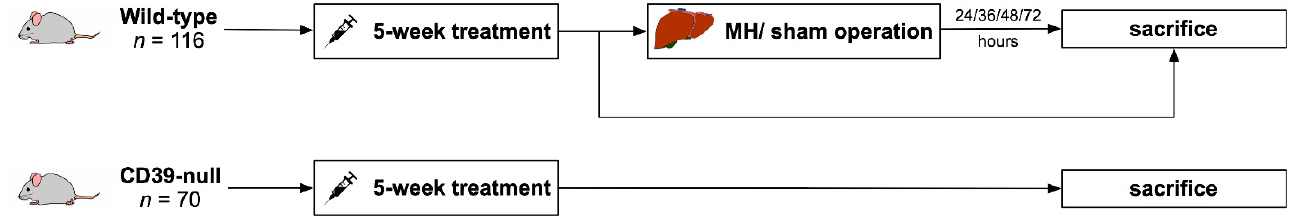
Figure 1. Project overview. wt ( n = 116) and CD39-null mice ( n = 70) received weekly intraperitoneal injections of their respective treatment (oxaliplatin alone, oxaliplatin and anti-VEGF, anti-VEGF alone, or glucose) over a time period of five weeks. Afterwards, wt mice were subjected to MH or sacrifice based on their general health. Instead of MH, some received a sham operation. Mice were sacrificed after 24, 36, 48, or 72 h after MH. All CD39-null mice were sacrificed after the five-week treatment period.